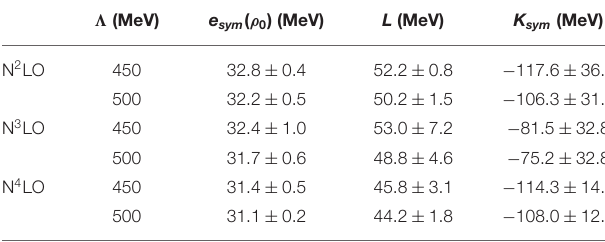
TABLE 4 | Predicted values of symmetry energy and related properties at three orders of chiral perturbation theory and two values of the cutoff parameter obtained as explained in the